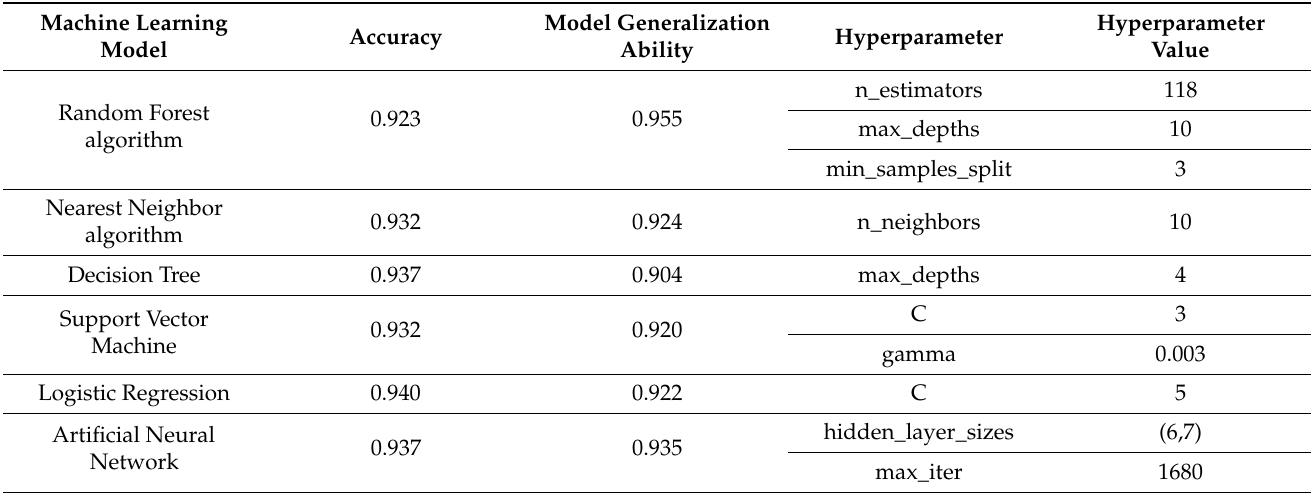
Table 5. Comparison of partial hyperparameter optimization and model evaluation of six machine learning